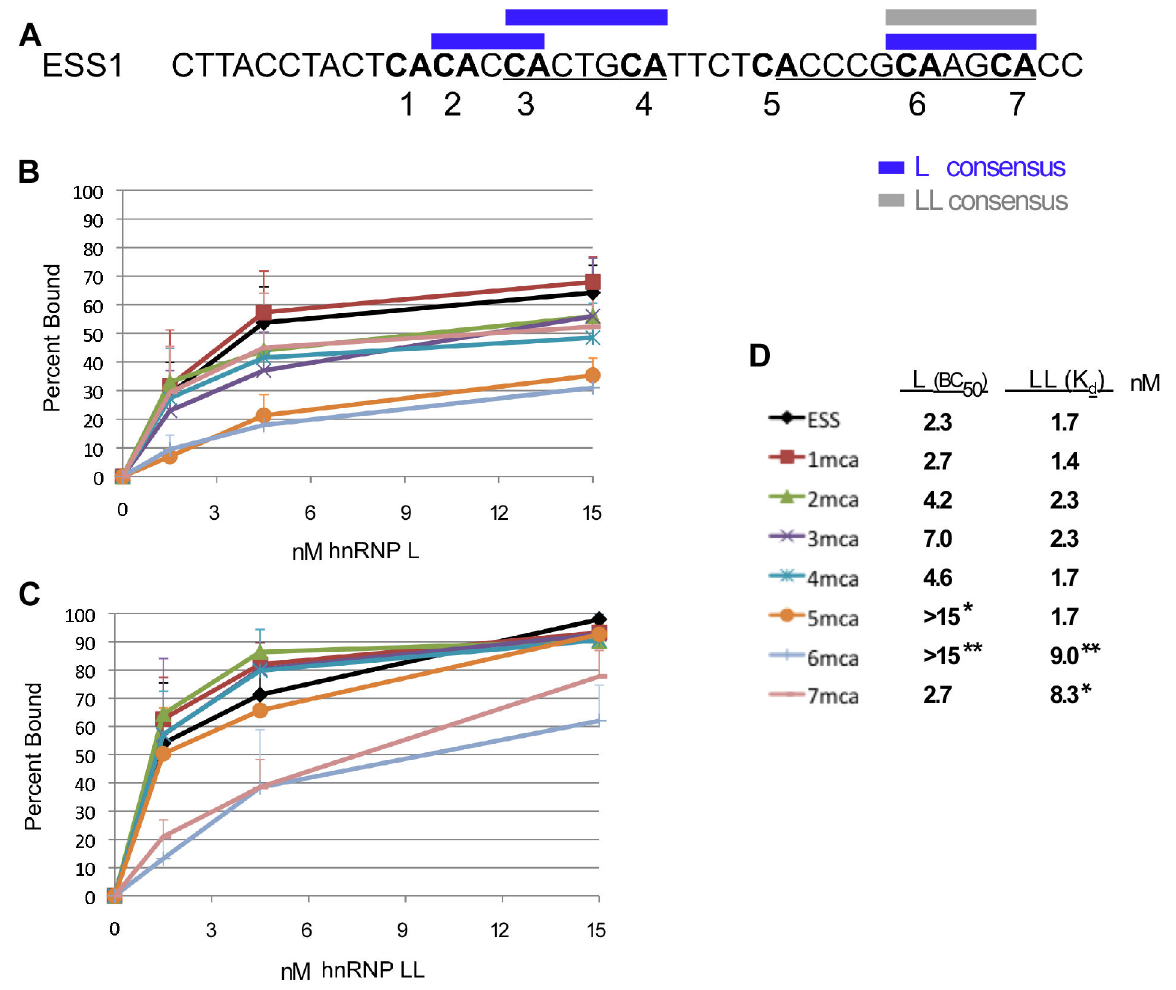
Figure 6. HnRNP L and hnRNP LL have different sensitivity to mutation of individual CA dinucleotides within the CD45 exon 4 ESS1 element. (A) Sequence of the ESS1 element from CD45 exon 4 with ARS element underlined, CA dinucleotides in bold and numbered consecutively, and segments that correspond to the above-described binding consensus for hnRNP L (L) or hnRNP LL (LL) are indicated in blue and grey respectively. (B) Binding curve for hnRNP L, as calculated from a minimum of three EMSAs, for the wildtype ESS1 or variants that are mutated at individual CAs (see panel D for legend). (C) Binding curve for hnRNP LL as described in panel B. (D) Legend for binding curves in panels B and C along with the apparent affinities for each RNA-protein combination as derived from the binding curves. Asterisks indicate affinities (concentration of 50% binding = BC significantly different from ESS (* p<0.05, ** p<0.01), as calculated by a unpaired